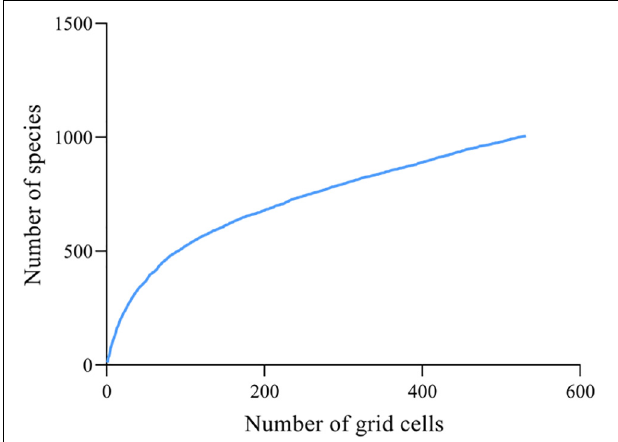
FIGURE 1 | Species accumulation curves for planthoppers in China.